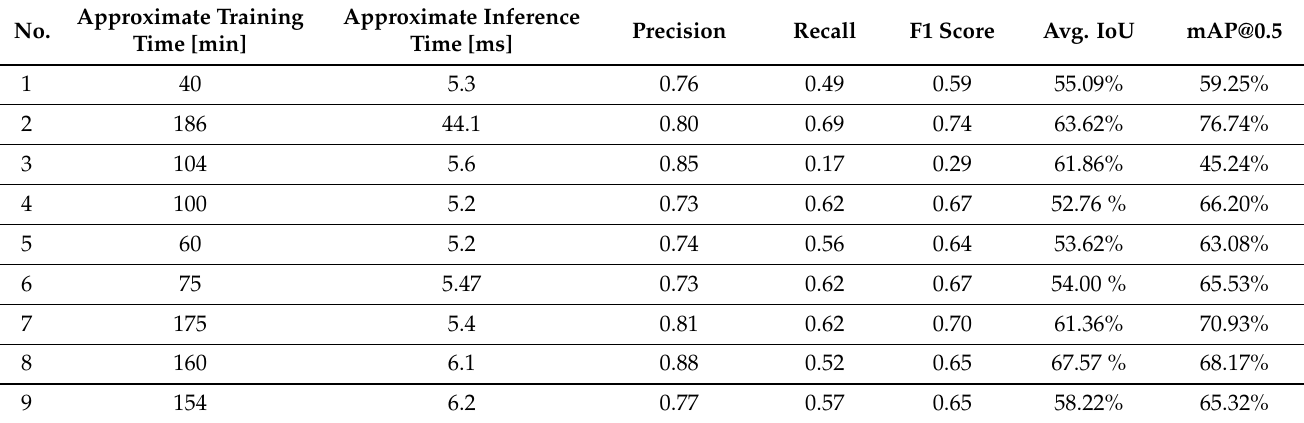
Table 2. Test results of the different YOLOv4-tiny configurations